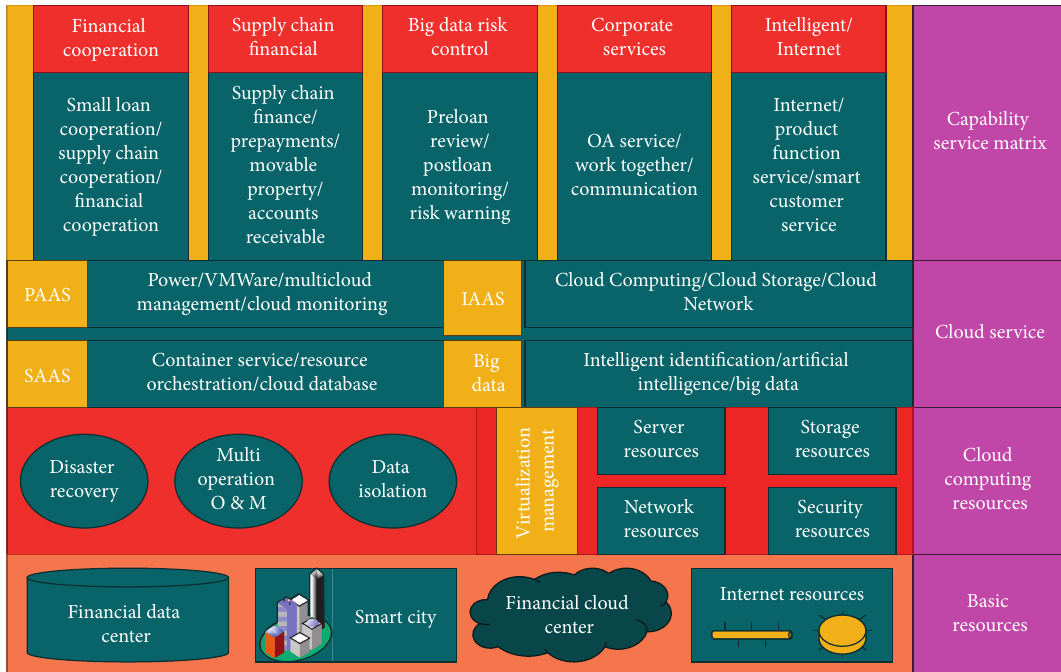
Figure 1: Smart financial